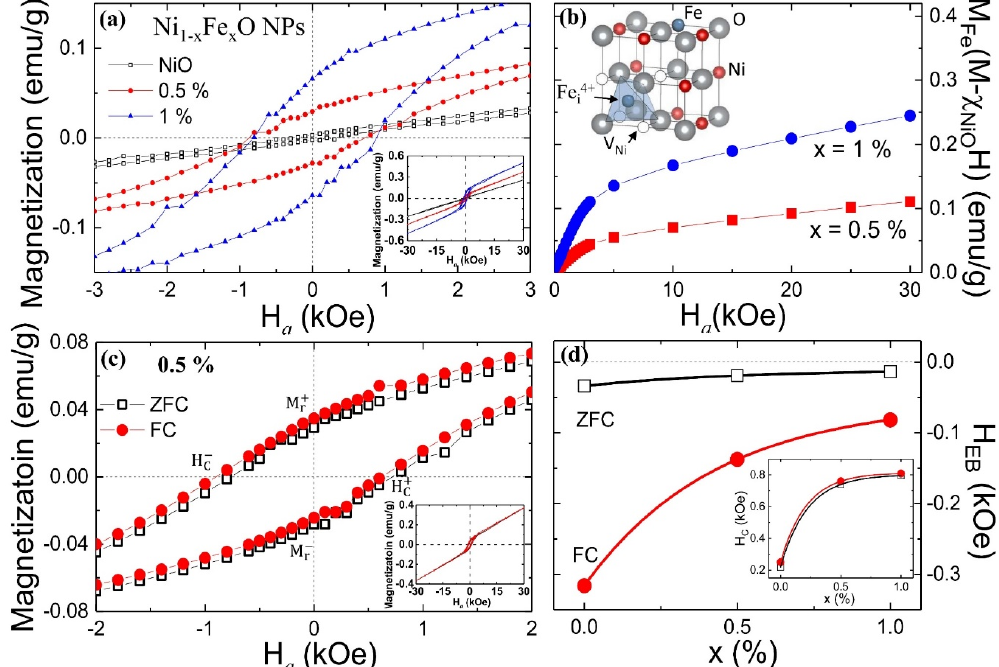
Figure 3. ( a ) Magnified ZFC-M(H a ) loops near zero-field from Ni 1-x Fe x O NPs at 300 K. ( b ) Field dependent magnetization M Fe (M-χ NiO H) from 0.5% and 1% samples. ( c ) Magnified ZFC-FC M(H a ) loop measured at 300 K from 0.5% sample. ( d ) Composition x dependency of exchange-bias field H EB .